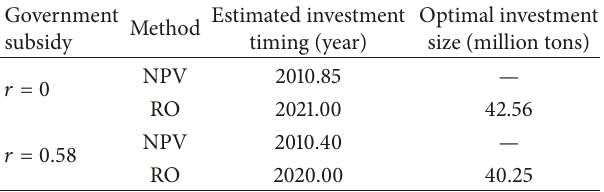
Figure 9: Option value and NPV of introducing different sizes of logistics parks with government subsidies. Table 4: Estimated timing of investment and optimal investment size in logistics